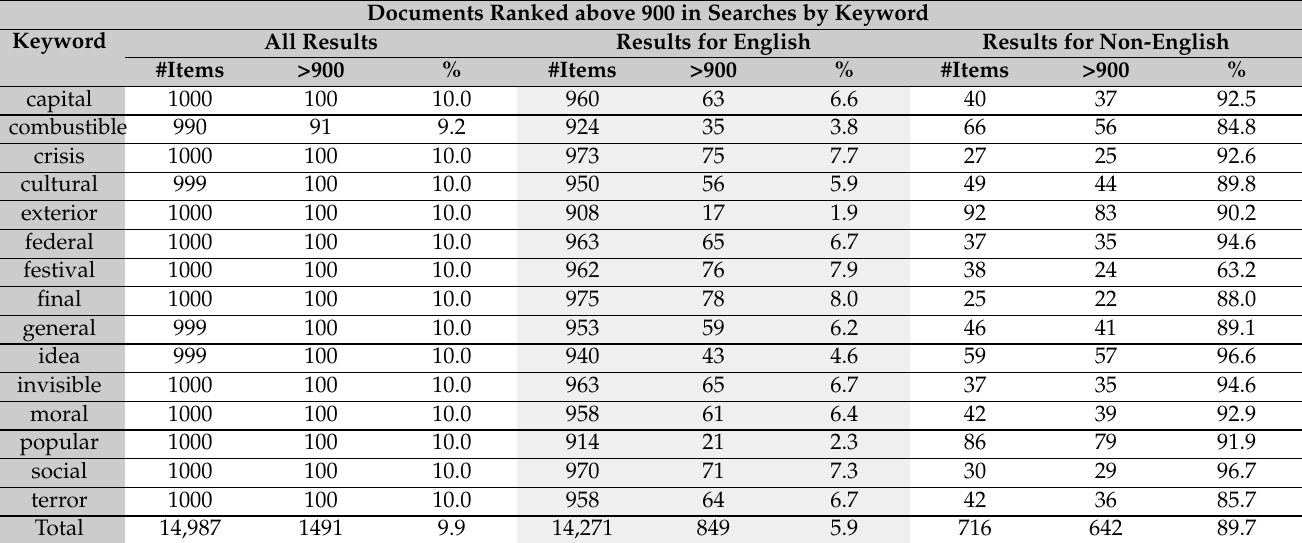
Table 4. Number of documents ranked above 900 in the case of searches by keyword.